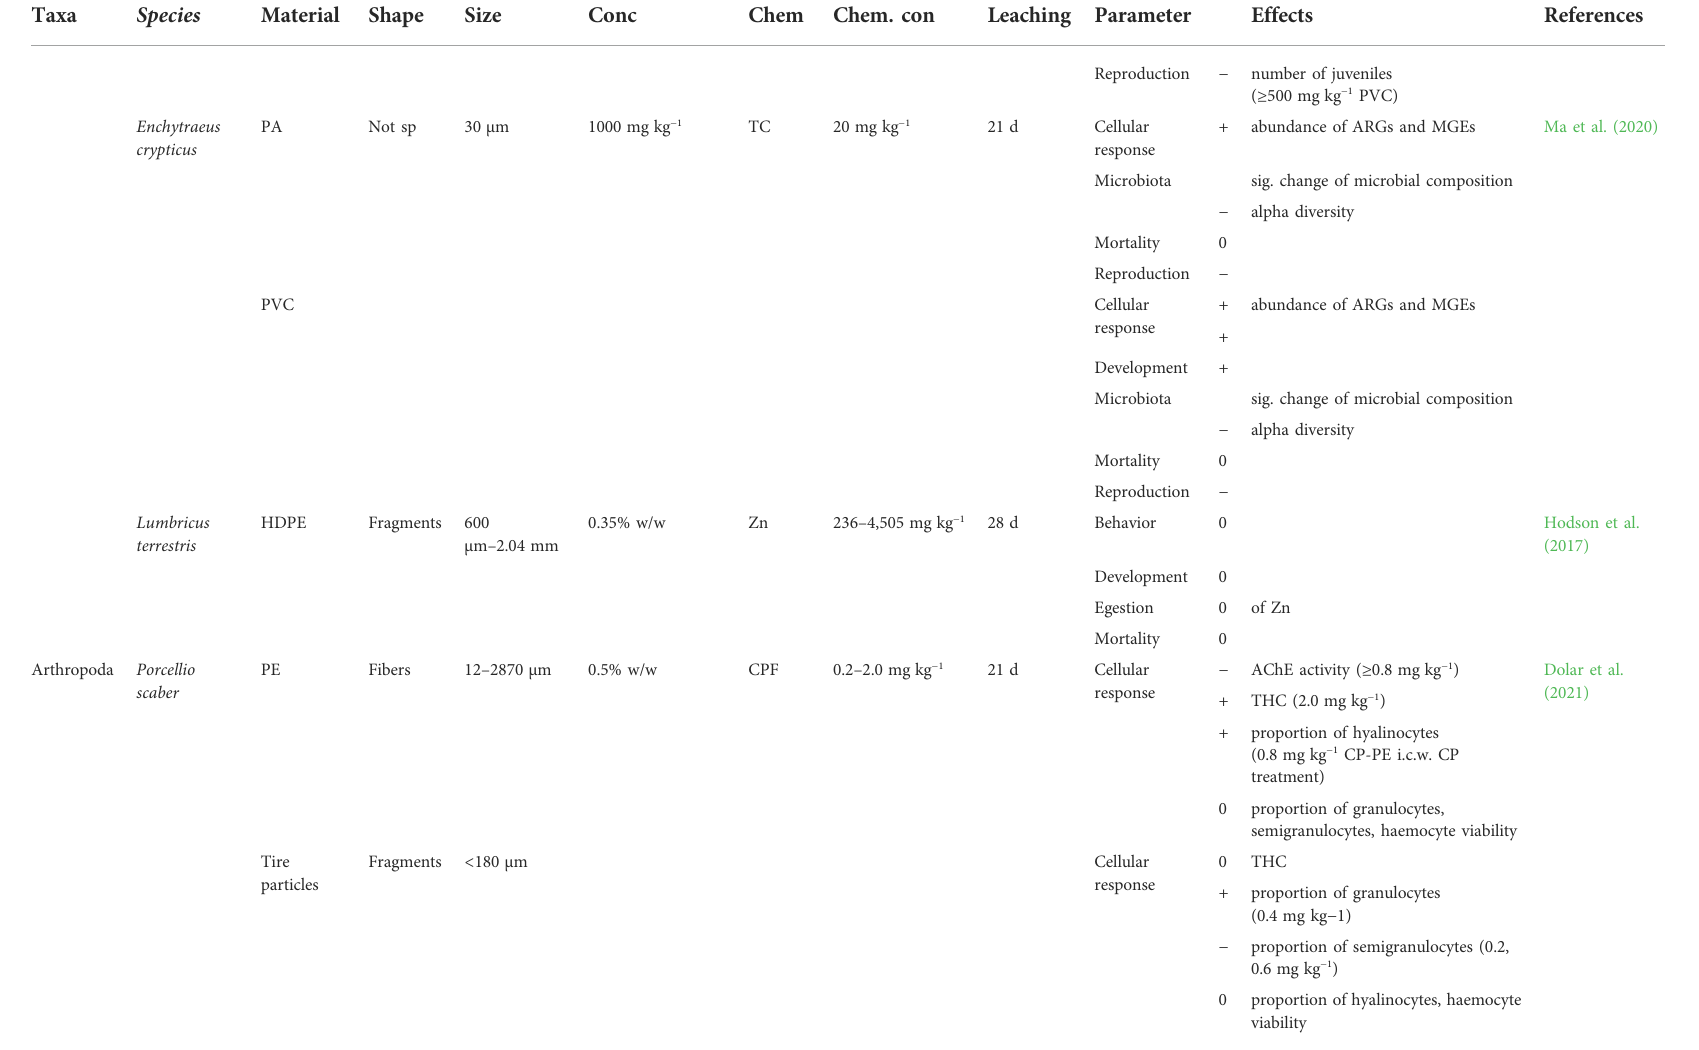
Theparametersarelistedinalphabeticalorder.Abbreviations:ATZ=atrazine,C=control,CPF=chlorpyrifos,d=days,i.c.w.=incomparisonwith,notsp.=notspeci fi edPHE=phenanthrene.Theconcentrationsoftheappliedmicroplasticarestatedfor dry soil unless stated otherwise. The parameter development applies to biomass (fw) unless stated otherwise. The chemical abbreviations are de fi ned in the text. All effects are based on comparison with the control treatment unless stated